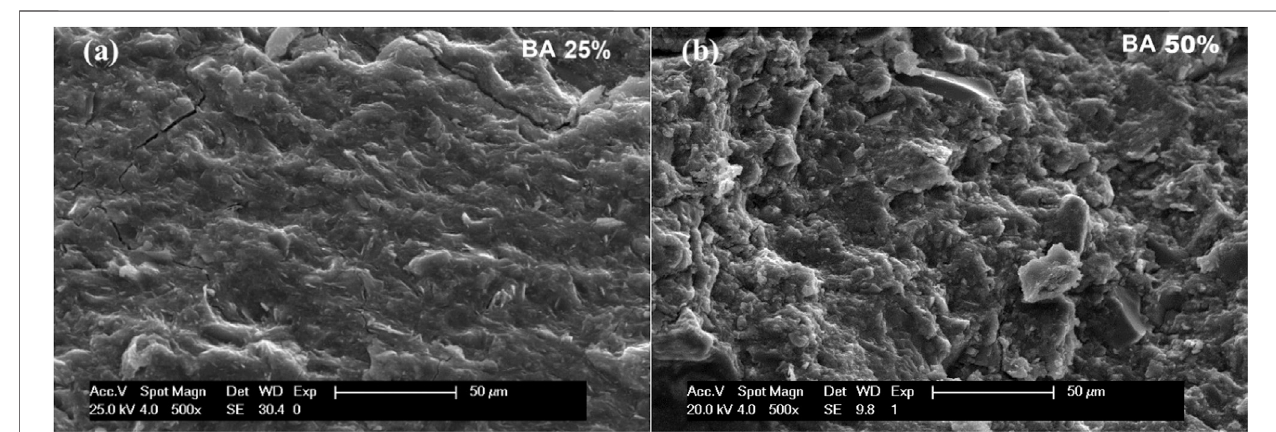
FIGURE 9 | Microstructure of (A) BA25-W_CF/EP0 and (B) BA50-W_CF/EP0 (fracture surfaces).